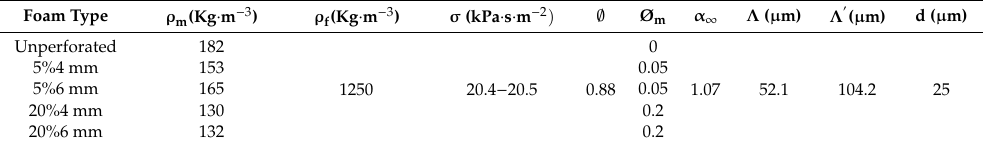
Table 3. Acoustic parameters of the samples measured. Bulk density of the material ( ρ m ), density of the fibers ( ρ f ), airflow resistivity ( σ ), porosity (ø), meso-porosity ( o M ), tortuosity ( α ∞ ), viscous characteristics length ( Λ ), thermal characteristics length ( Λ (cid:48) ), and mean fiber diameter (d). Figure 13. Normal incidence plane wave sound absorption coefficient of the RPU samples for D = 4 mm. Comparison between measurement ( continuous lines ) theoretical model ( dashed lines ) and Foam Type numerical model ( dotted lines ).